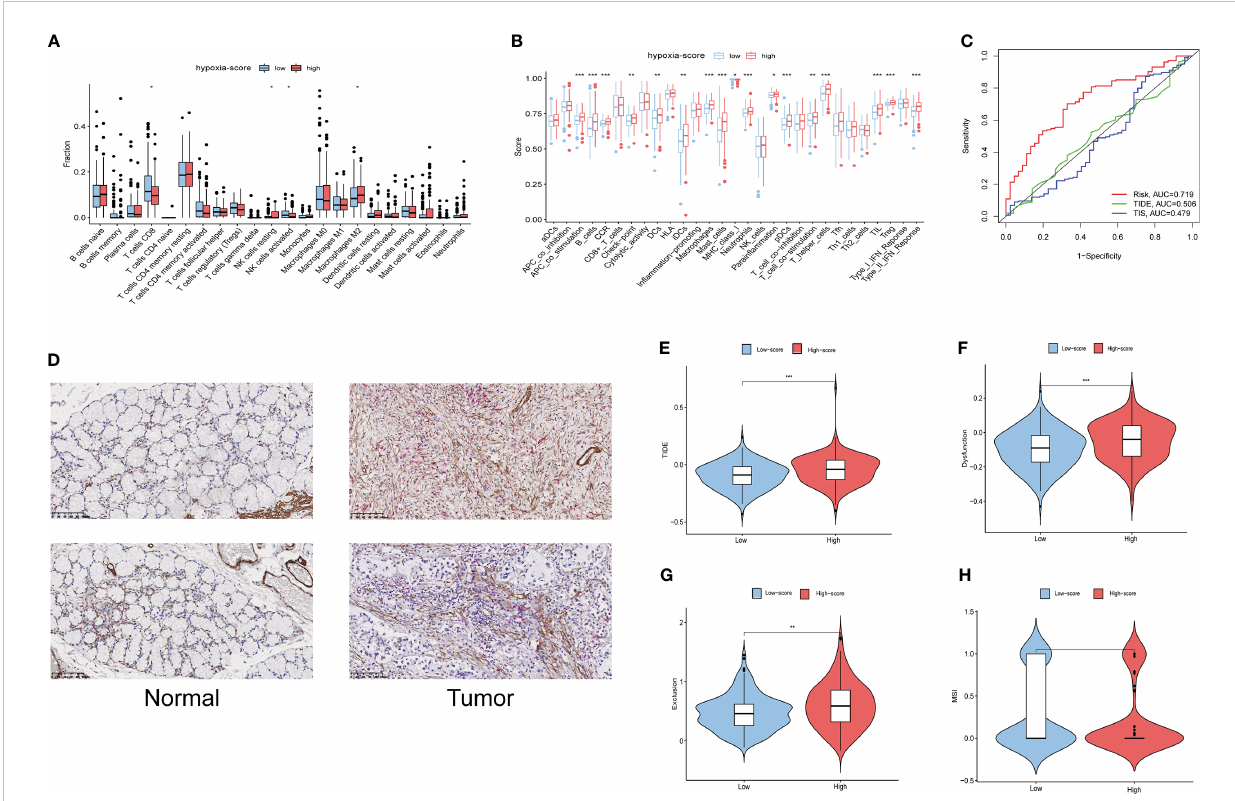
FIGURE 6 Immune in fi ltration and prognostic values of immunotherapy in different hypoxia score groups. (A) The fractions of 22 immune cells between the low and high hypoxia score groups by the CIBERSORT method. (B) The scores of 29 functional cells between the low and high hypoxia score groups. (C) ROC curves of the hypoxia score, TIDE and TIS to predict the OS of GC patients in TCGA cohorts. (D) The fi nding of immune in fi ltration was validated by a dual immunohistochemistry staining(ACTA2 and CD8). (E – H) . Differences in TIDE, T-cell exclusion score, T-cell dysfunction score and MSI in the two hypoxia score subgroups. * means p<0.05; ** means p<0.01; *** means